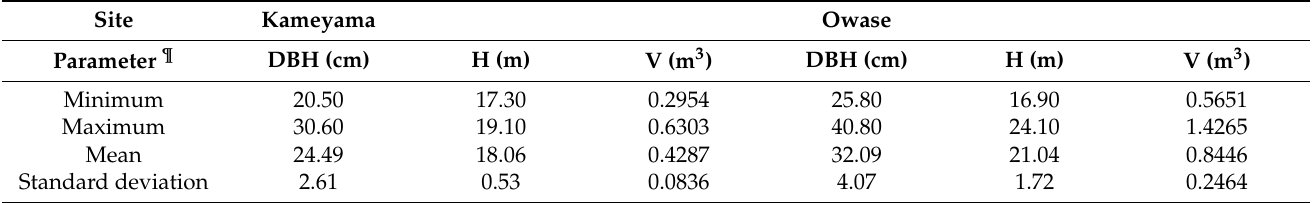
Table 2. Summary of the descriptive statistics of tree parameters for Kameyama and Owase